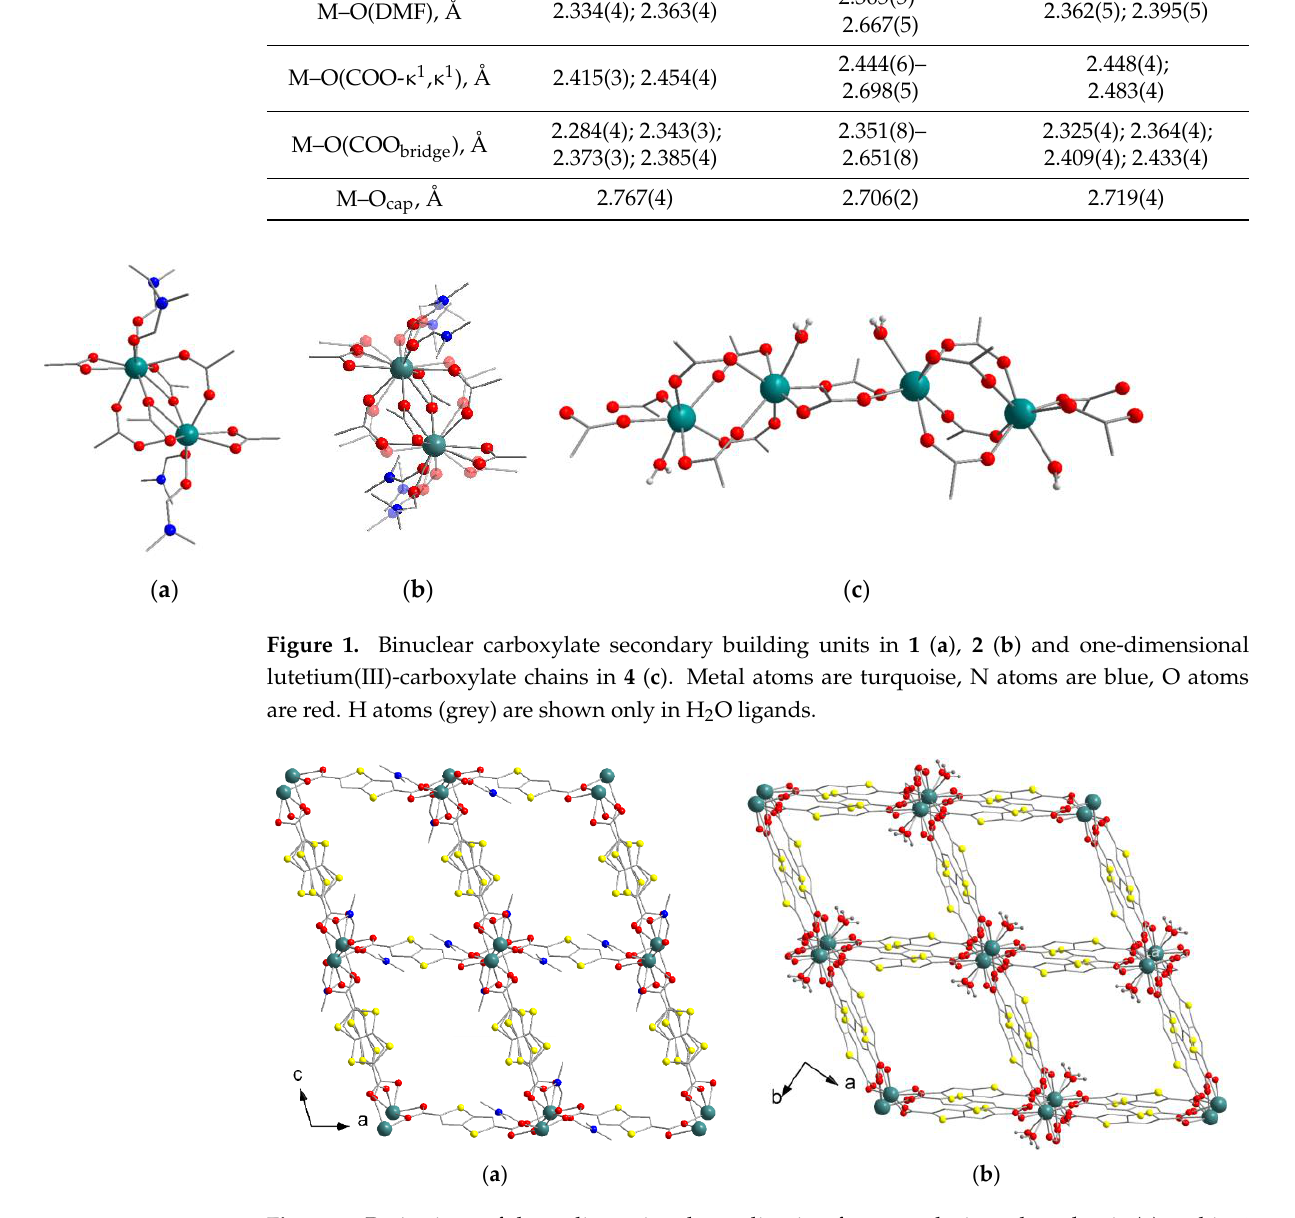
Figure 2. Projections of three-dimensional coordination frameworks in 1 along b axis ( a ) and in 4 along c axis ( b ). Ln atoms are turquoise, N atoms are blue, O atoms are red, S atoms are yellow. H atoms (grey) are shown only in water molecules.